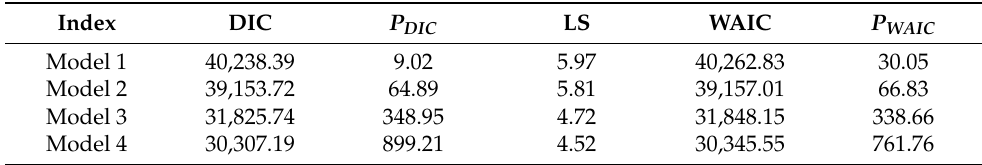
Table 2. Bayesian modeling evaluations of the alternative regressions for China’s tourism case account for model fitness, complexity, and predictive power.